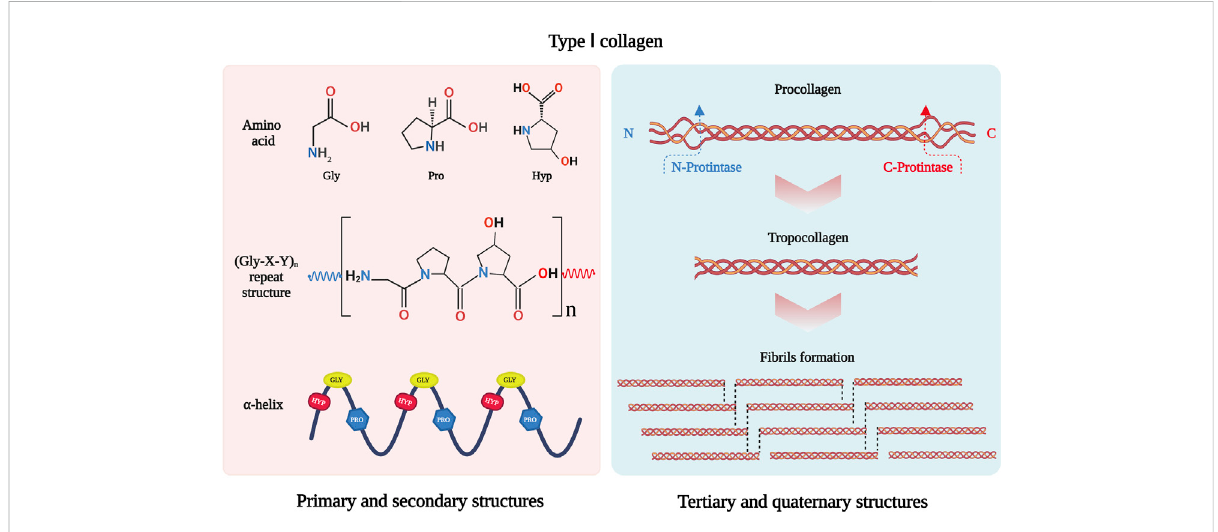
FIGURE 1 Schematic drawing of type I collagen structure. Gly-X-Y is the repeating peptide triplets. X and Y position is often occupied by proline and hydroxyproline. There α -chains are woven together to form procollagen with triple helix. Type I collagen is synthesized in vivo in the form of procollagen. The N- and C-terminal propeptides of procollagen are cleaved off by special enzymatic hydrolysis to form troprocollagen, and trigger spontaneous assembly to form fi brils. This fi gure was created with